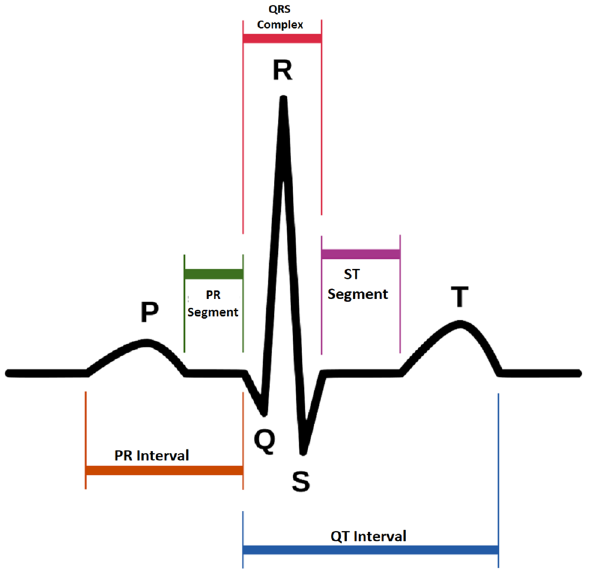
Figure 1. Morphology of a normal